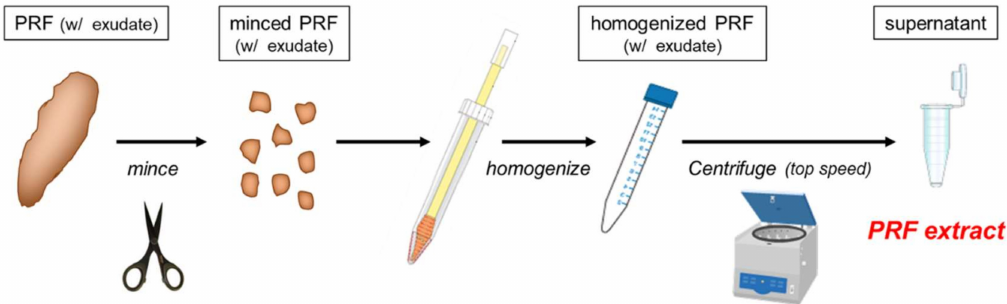
Figure 9. Graphic summary of preparation of platelet-rich fibrin (PRF)